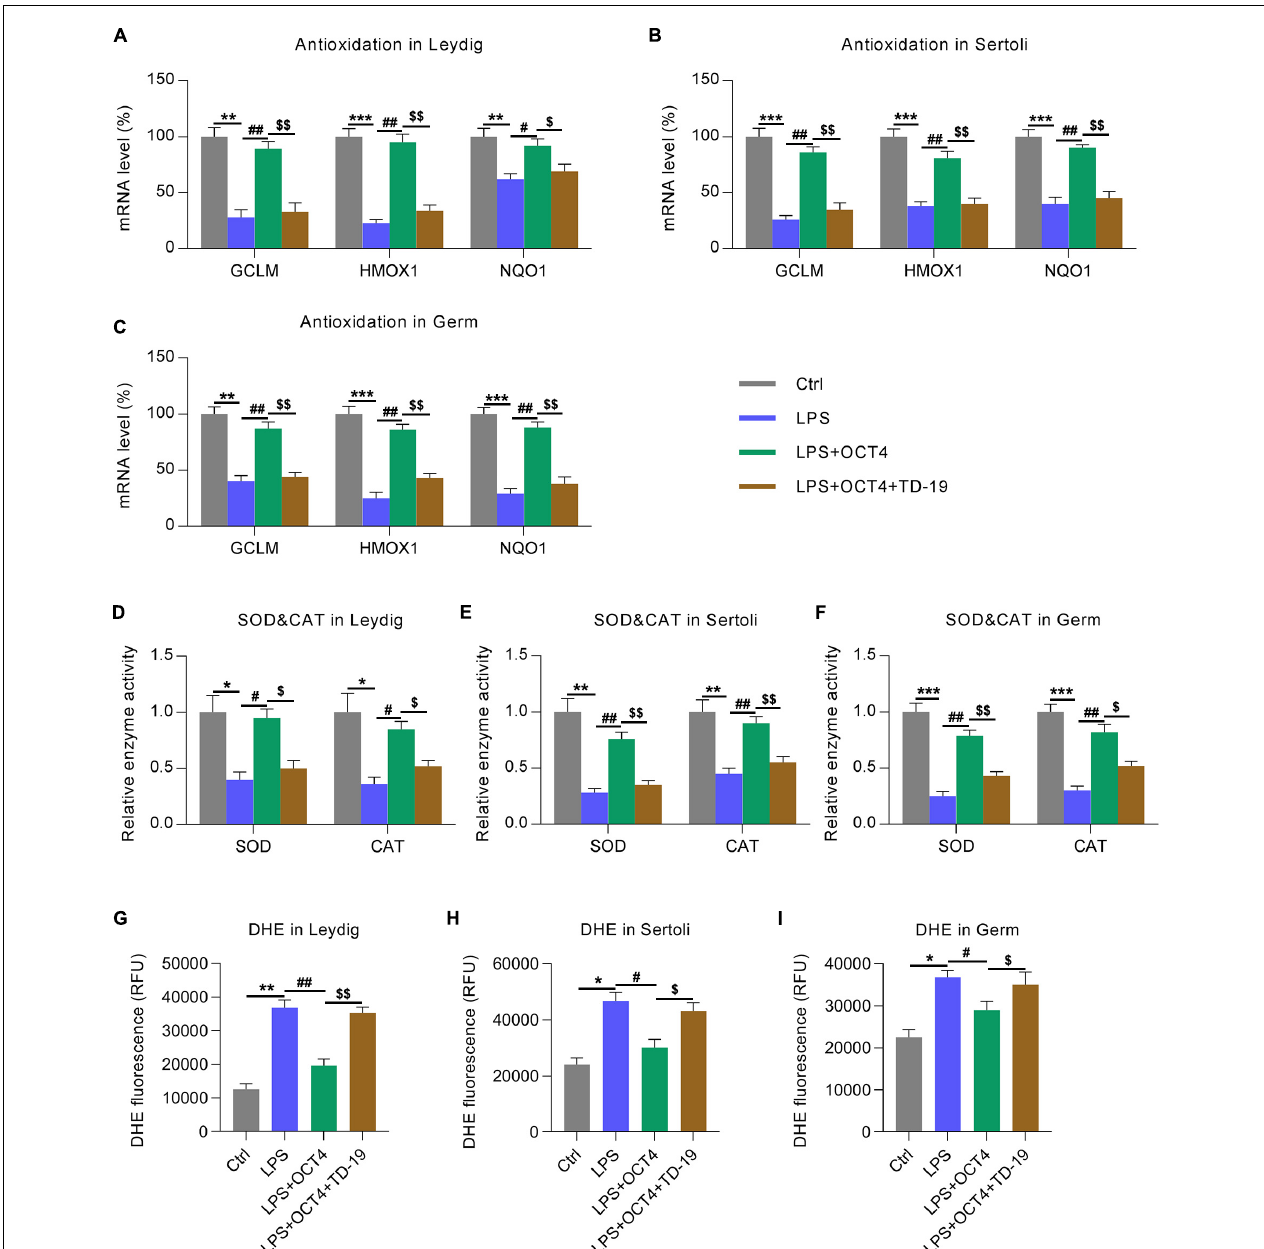
FIGURE 8 | Effects of OCT4 and CIP2A on antioxidant gene expression in LPS-induced Sertoli, Leydig, and germ cells. Leydig, Sertoli, and germ cells were transfected with pcDNA3-OCT4 or pcDNA3-NC and then incubated with LPS and TD-19 for 12 h. (A–C) The levels of antioxidation-associated genes in the cells were determined by RT-qPCR. (D–F) SOD and CAT activity in the cells was examined. (G–I) The DHE assay was carried out to detect the ROS generation in the cells. Data are expressed as the means ± SDs. * P < 0.05, ** P < 0.01, *** P < 0.001, Ctrl vs. LPS; # P < 0.05, ## P < 0.01, LPS vs. LPS + OCT4; $ P < 0.05, $$ P < 0.01, LPS + OCT4 vs. LPS + OCT4 +